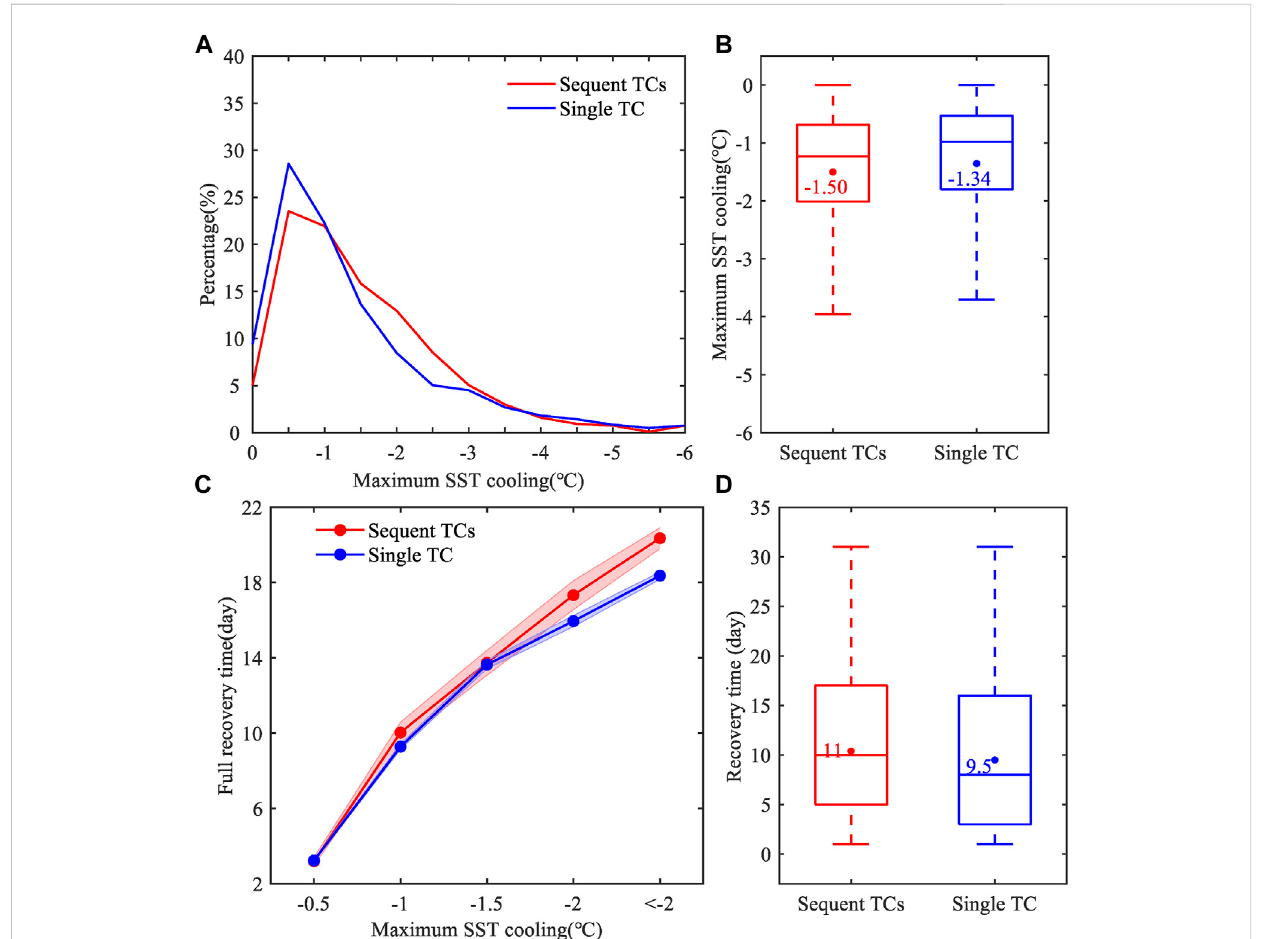
FIGURE 3 (A) Probabilitydensityfunctionand (C) TherecoverytimeasafunctionofmaximumSSTcooling.BoxplotsofmaximumSSTcooling (B) andrecovery time (D) .Insubgraph (B) and (D) ,thedotsinboxesdenotetheaveragedvalues.ThelargermaximumSSTcoolinginthesequentTCsconditionthanthatin thesingleTCconditionissigni fi cantabovethe95%con fi dencelevelbasedontheStudent ’